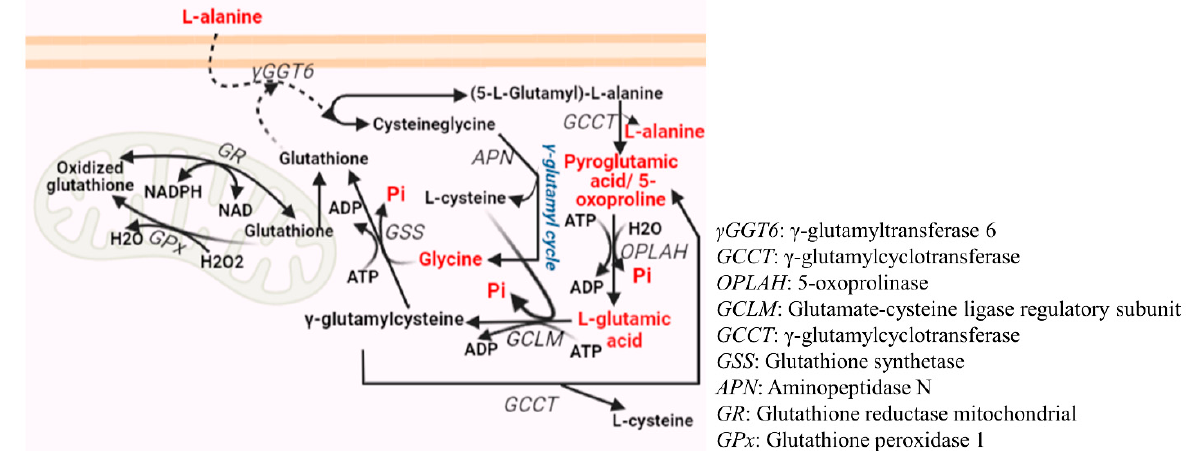
Figure 3. Glutathione (GSH) Metabolism Overview: L-glutamic acid, cysteine, and glycine sequen- tially synthesize GSH by glutamylcysteine synthetase and GSH synthetase, respectively. L-glutamic acid and cysteine are combined by glutamate-cysteine ligase, which is powered by ATP, to form γ -glutamylcysteine. The enzyme glutathione synthetase, which is also powered by ATP, can synthesize γ -glutamylcysteine and glycine. GSH exists in two states: oxidized (GSSG) and reduced (GSH). GSH oxidation occurs as a result of a relatively high GSH concentration within cells. Figure created with BioRender.com. (Note: Metabolites—L-alanine, 5-oxoproline/pyroglutamic acid, L-glutamic acid, glycine, and phosphoric acid (Pi)—matching the user-uploaded data with the 28 metabolites listed by MetaboAnalyst are indicated in red text).